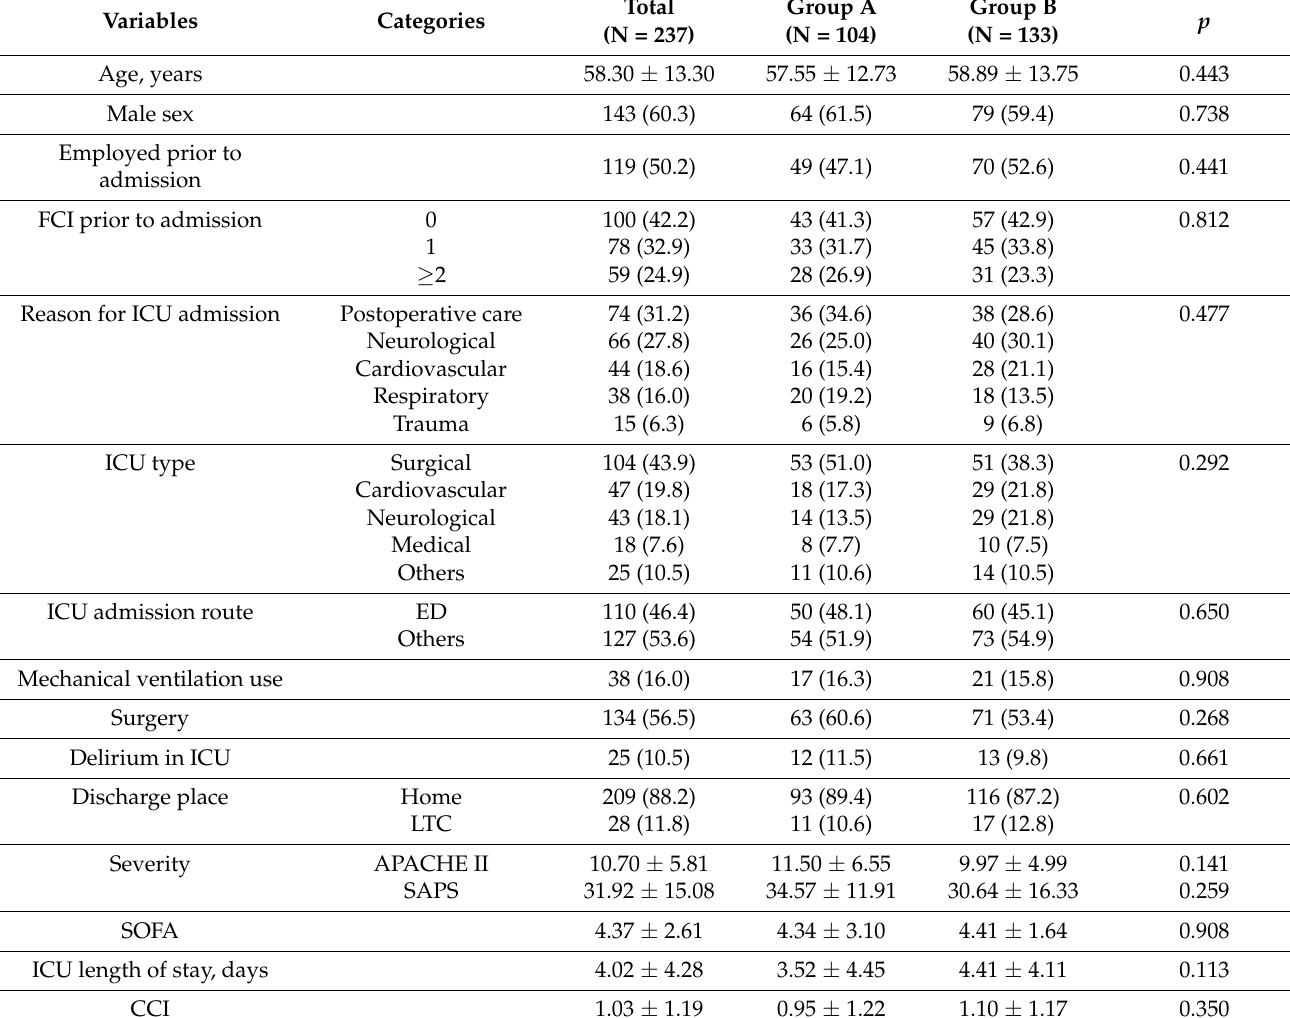
Table 1. Baseline